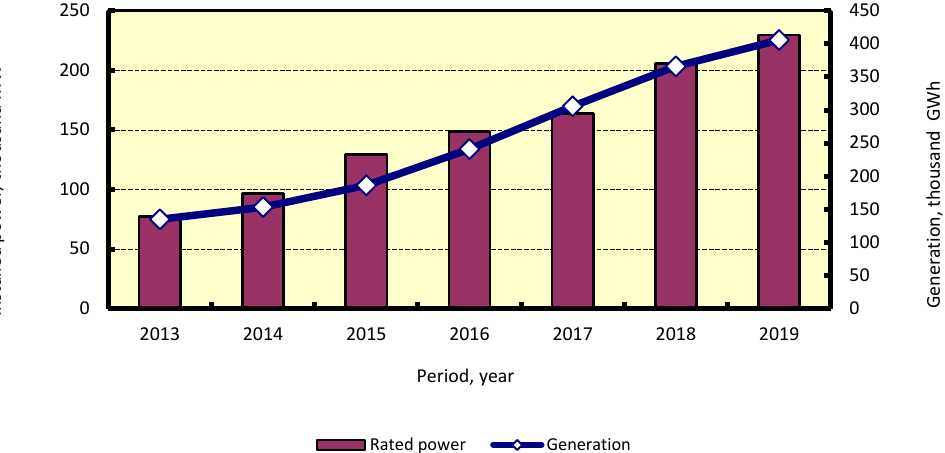
Figure 14. Onshore wind farm installations and electricity generation history.